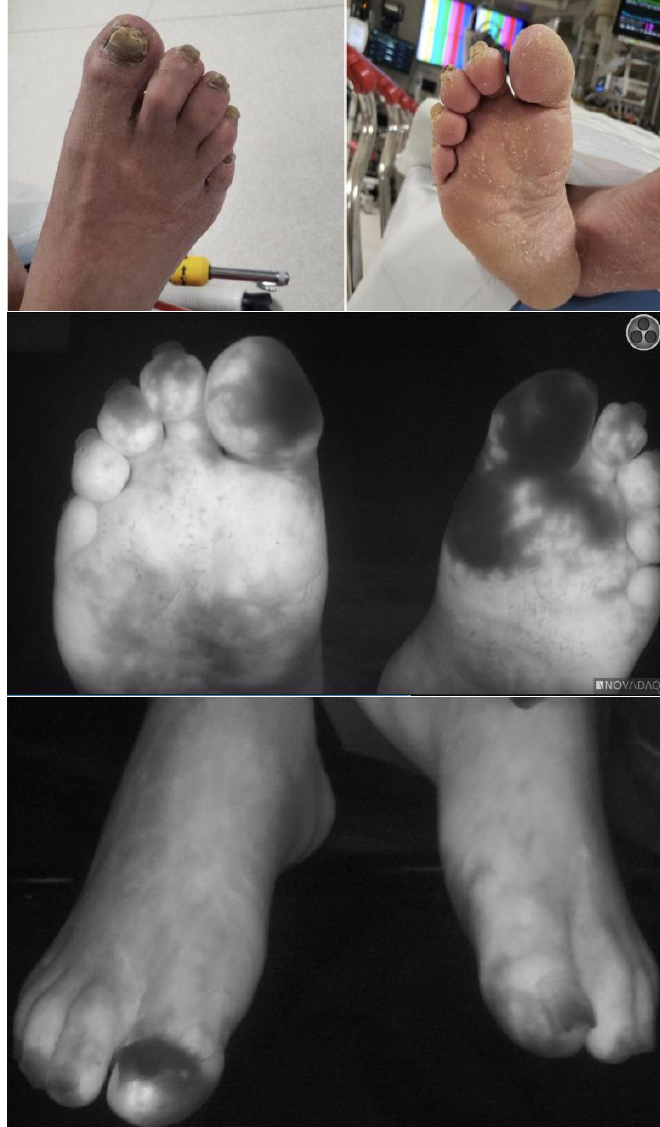
Figure 1. Use of bedside fluorescence microangiography in the emergency department for evaluation of a patient with possible frostbite. Lack of fluorescence (dark colored tissue in photos) indicates no fluorescein perfusion.